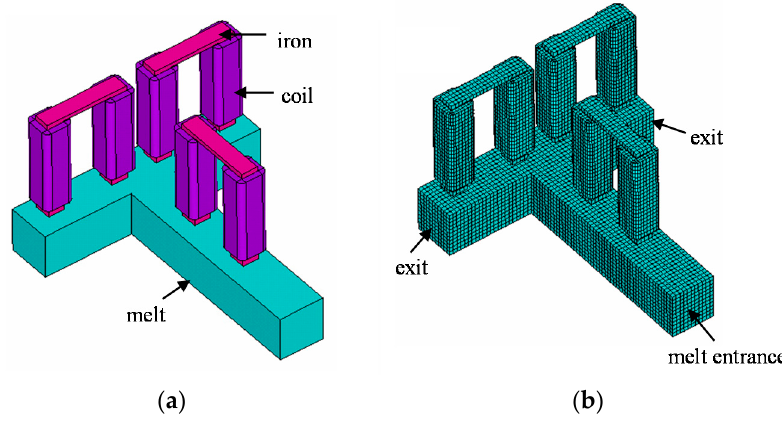
Figure 3. ( a ) 3D physical model for simulation; ( b ) mesh model and boundaries.